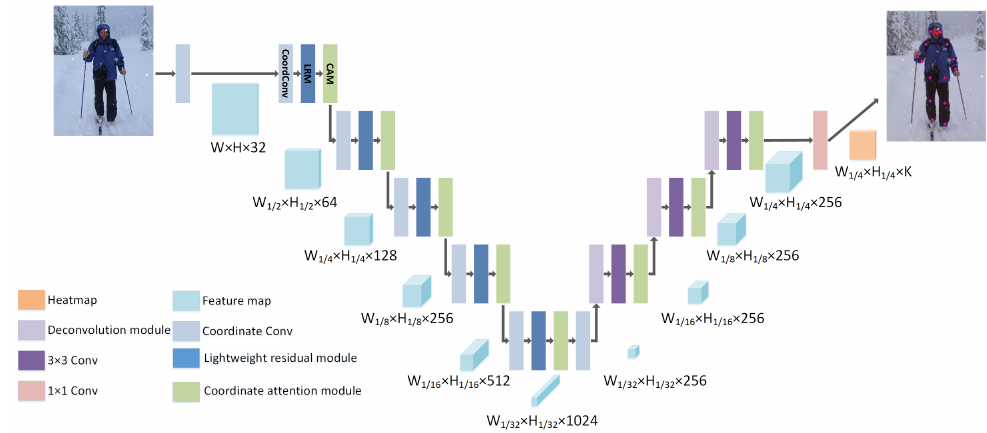
Figure 1. The framework of our networks. The network extracts keypoints by encoding and decoding, focusing on coordinate position information at each stage to achieve highly accurate pose